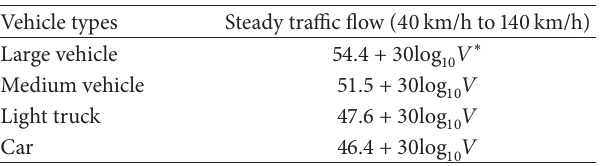
Table 2: A-weighted sound power levels ( 𝐿 graded asphalt (DGA)